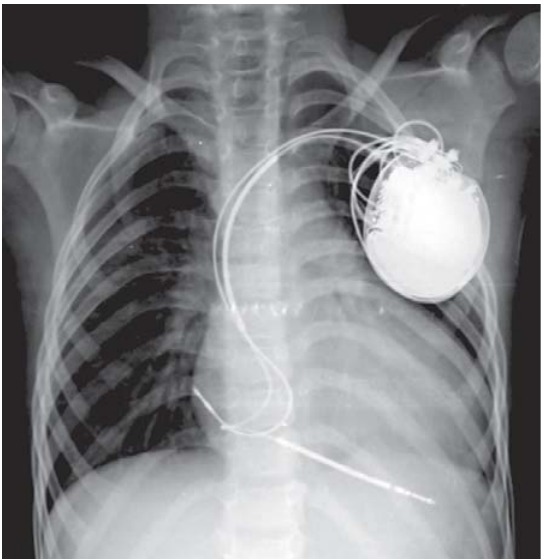
Fig. 4 – Radiografia de tórax no pós-operatório imediato com os eletrodos atrial e ventricular implantados